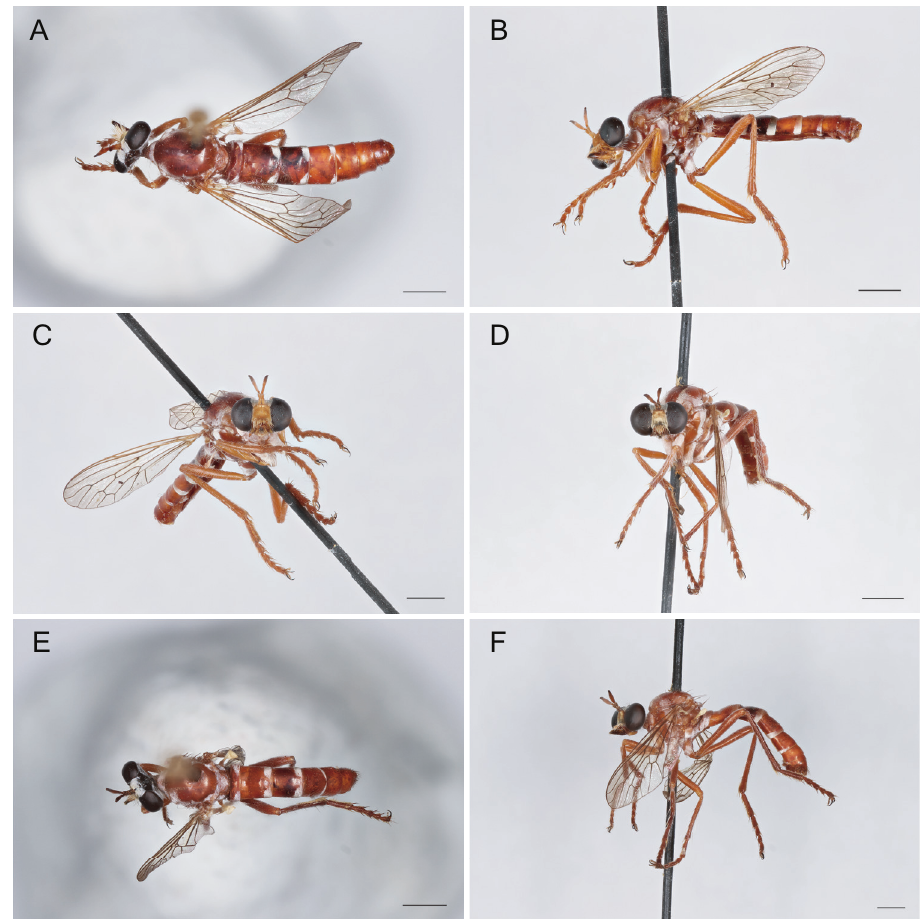
Figure 23. Saropogon pyrodes sp. nov. paratype female: A dorsal view B lateral view C anterior view; holotype male: D anterior view E dorsal view F lateral view. Scale bars: 2